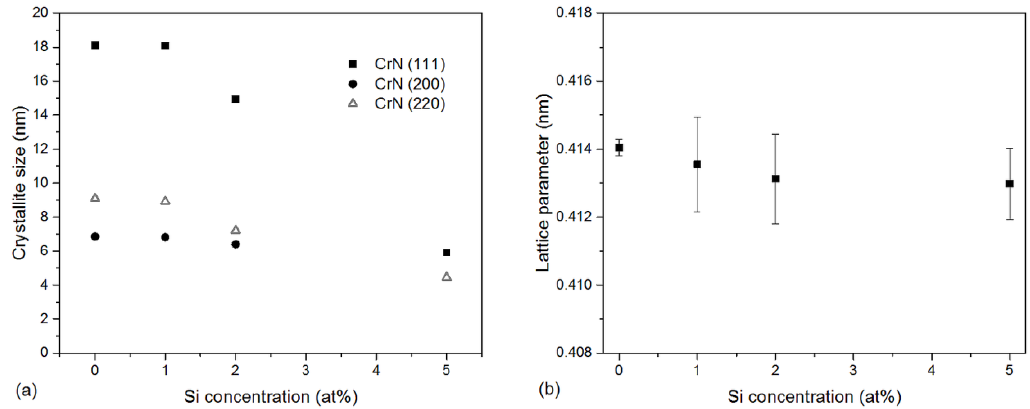
Figure 4. Texture coefficient of the CrN and AlCrSiN coatings formed from Cr cathode and cathodes with silicon concentration ranged from 0 to 5 at%.